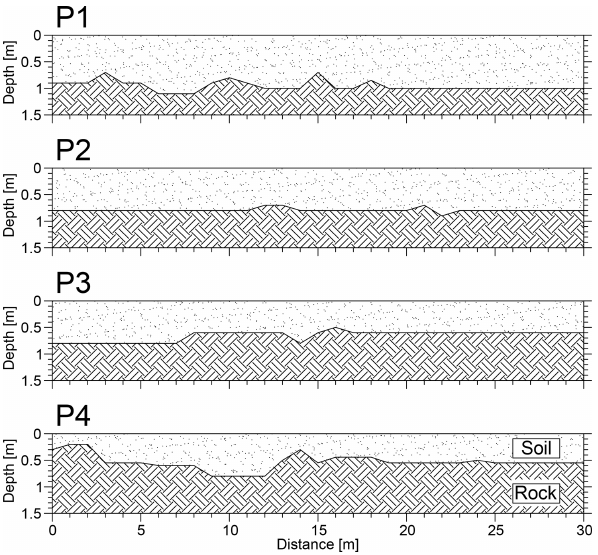
Figure 2. Measured spatial distribution of the soil depth along four experimental plots, P1, P2, P3 and